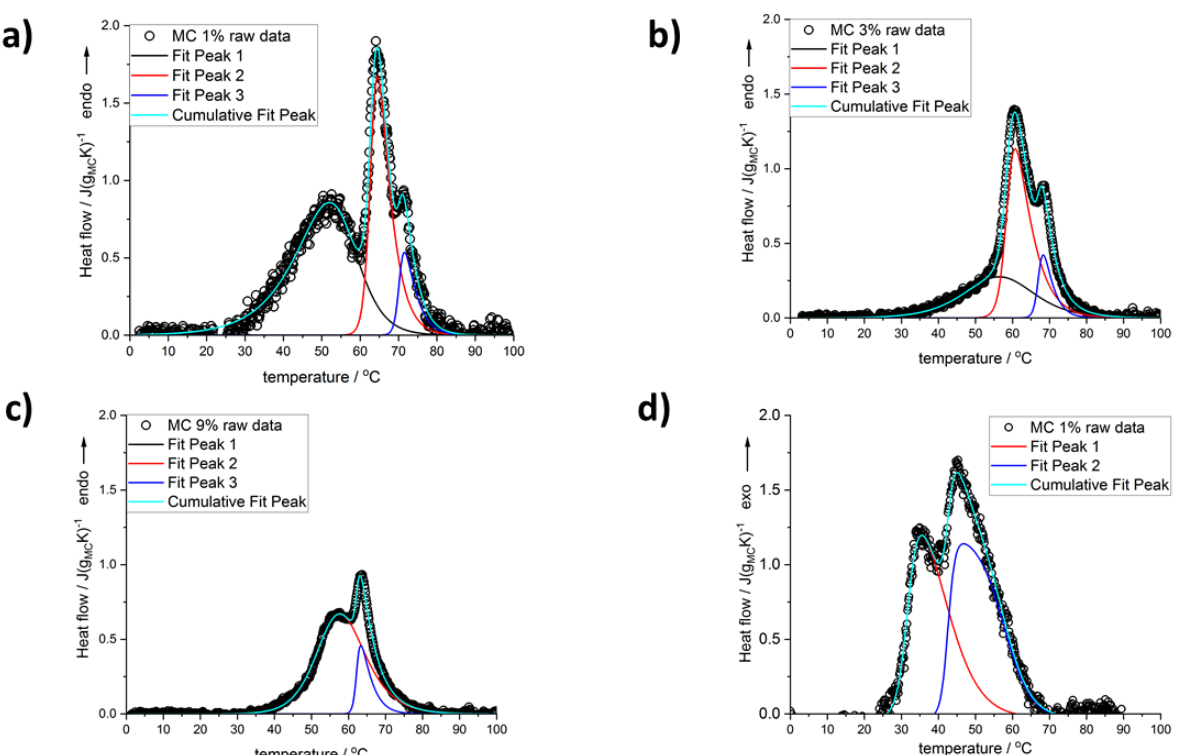
Figure 1. DSC scans registered during: ( a ) heating and ( b ) cooling for solutions of MC at mass con- tent as indicated, normalized to MC mass. Curves shifted in Y-axis for clearness.